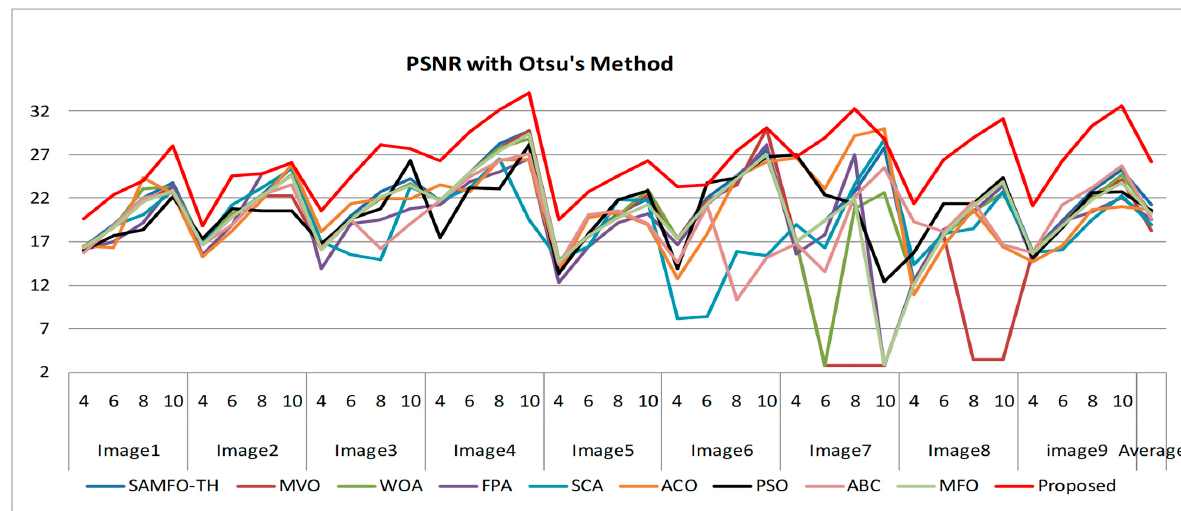
Figure 9. Comparison of PSNR based on Otsu’s method.